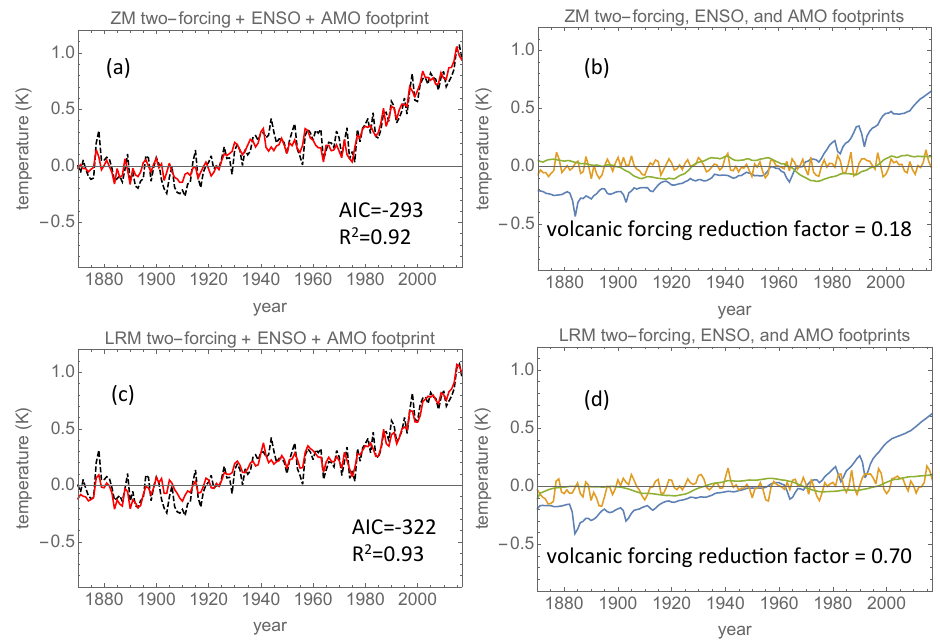
Figure 8. ( a ) The red curve is the total explained GMST (or the total footprint) from the regression when the fingerprints are the unfiltered solar and anthropogenic forcing, the unfiltered volcanic forcing, and the unfiltered ENSO and AMO indices. The black, dashed curve is the HadCrut4 GMST signal. ( b ) The individual footprints, whose sum is the red curve in panel ( a ). The blue curve is the total forcing, the yellow curve is the ENSO, and the green curve is the AMO footprints, respectively. Panels ( c , d ) show the results of the same analysis as panels ( a , b ), but with fingerprints filtered with β =